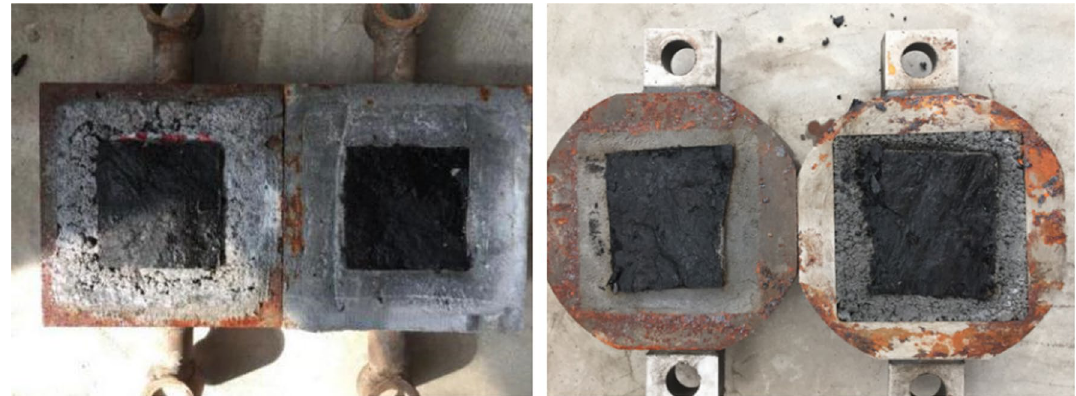
Figure 4. Shear creep failure planes of the coal samples.